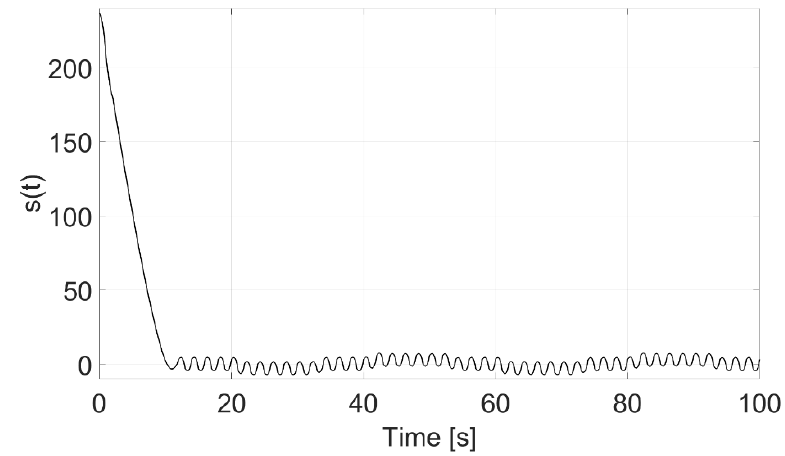
Figure 4. Sliding variable with the switching controller.